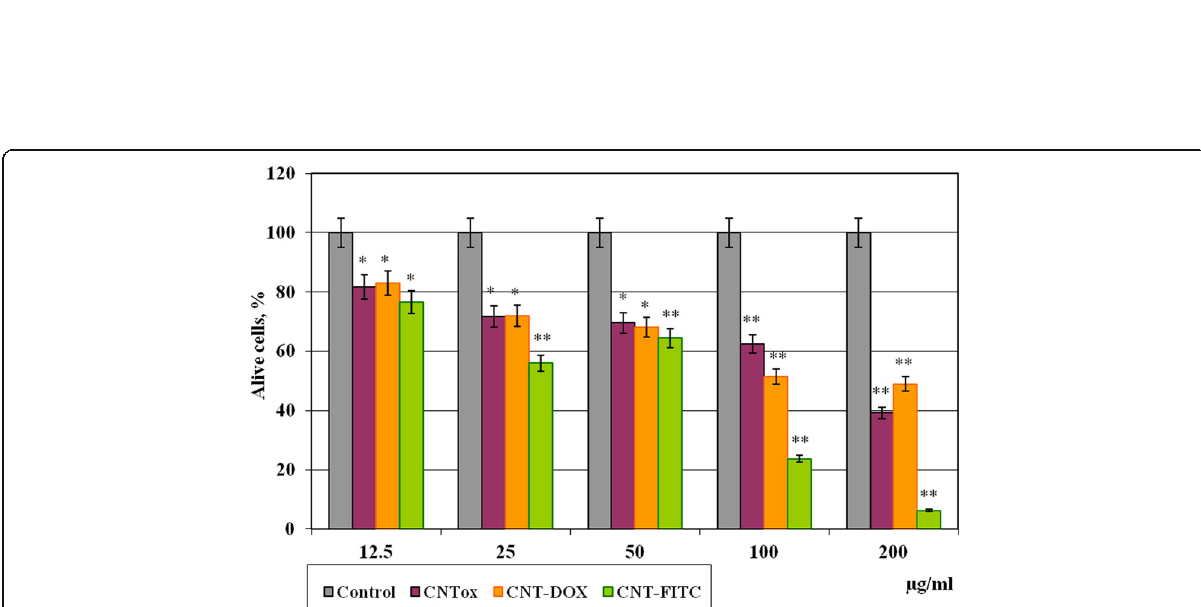
Fig. 5 Viability of tumor cells HT29 in monolayer culture after incubation during 48 h with CNTs and its derivatives (CNT-Dox and CNT-FITC). Statistical significance: * р ≤ 0.05 or ** р ≤